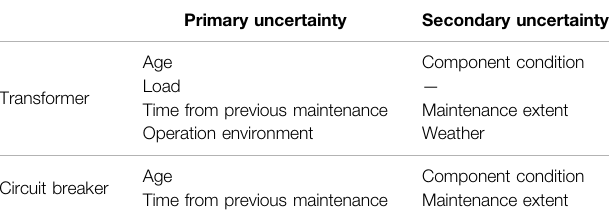
TABLE 1 | Operational variations and uncertainties in type 2 fuzzy rules for individual components.